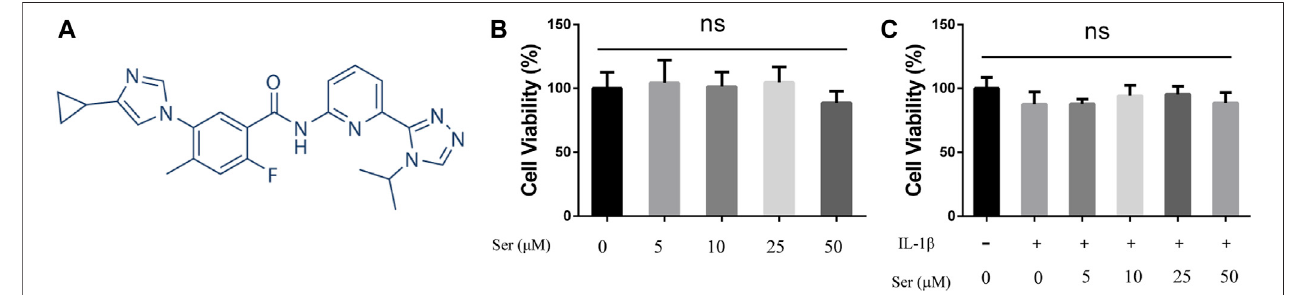
FIGURE2 | Ser attenuates IL-1 β -induced in fl ammatoryresponsesand cartilage matrix degradation in chondrocytes.Chondrocytes were treated withSer (25 μ M) intheabsenceorpresenceofIL-1 β (10 ng/ml)for24 h. (A) Westernblotand (B) quantitativeanalysisofiNOSandCOX2. (C) Westernblotand (D) quantitativeanalysisof collagen Ⅱ , MMP3 and ADAMTS5. GAPDH and β -ACTIN were used as the external control respectively. p p < 0.05, pp p < 0.01, n (cid:2) 3.